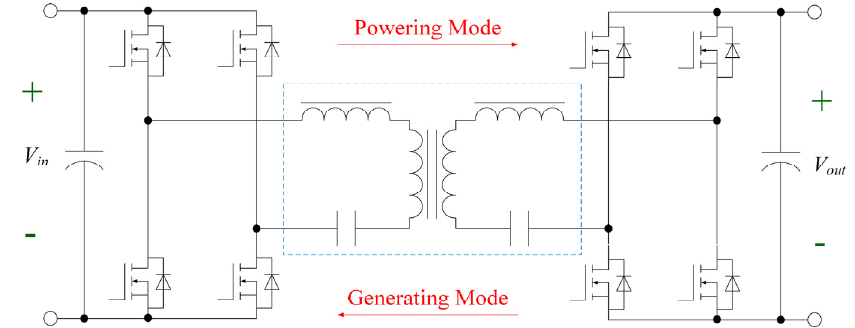
Figure 1. Bidirectional full-bridge CLLC resonant converter